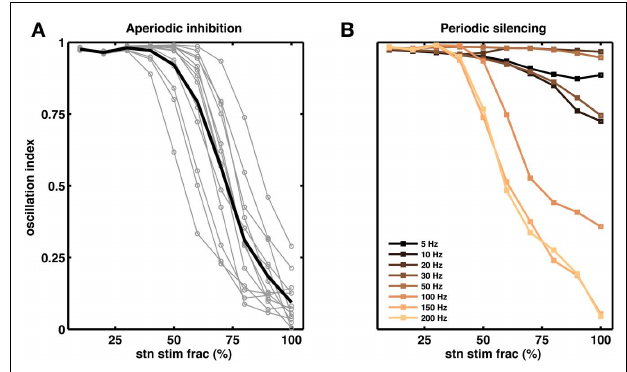
FIGURE 6 | Partial stimulation of STN neurons can quench oscillations. (A) Effect of extra inhibitory input to a fraction of STN neurons. Each gray line corresponds to a network with unique set of parameters.The black trace is the average of the gray traces. For all networks we injected extra Poisson type inhibitory inputs (50Hz). Out simulations suggests that for some networks inhibition of even 50% of the STN neurons is sufficient to reduce the oscillations (OI ≤ 0.3), on average however, ≥ 70% STN neurons should be inhibited to quench the oscillations (OI ≤ 0.3). (B) Effect of periodic silencing ( Figures 5F–J ) of excitatory input to a fraction of STN neurons. At high frequencies ( ≥ 100Hz) even partial stimulation of STN neurons ( ≥ 50%) is enough to reduce the oscillations in the STN-GPe